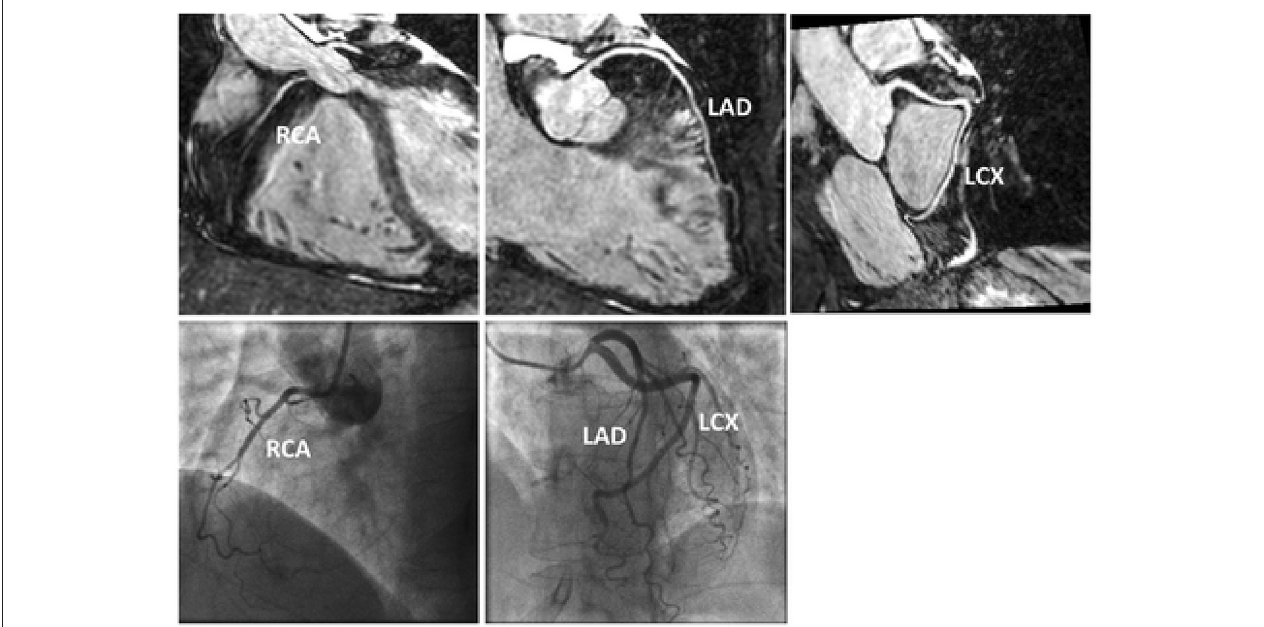
FIGURE 2 | Reformatted CMRA datasets (top row) from a patient without coronary artery disease but non dominant RCA. Coronary x-ray angiography in the same patient (bottom row). RCA, right coronary artery; LAD, left anterior descending artery; LCX, left circumflex artery. Adapted with permission from Henningsson et al. ( 52).